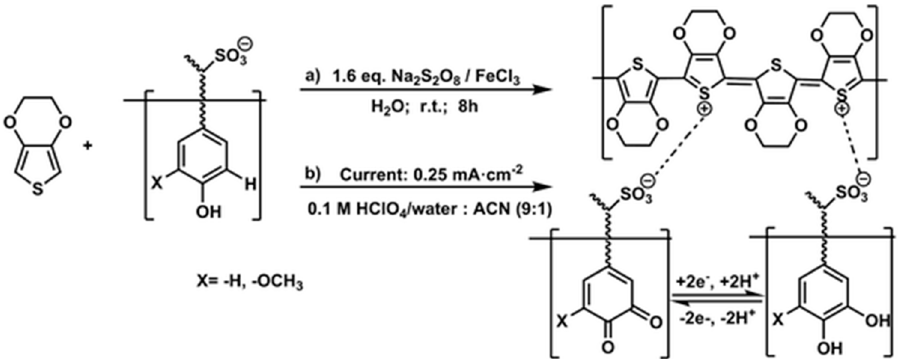
Figure 8. ( a ) Chemical oxidative and ( b ) electrochemical polymerizations of PEDOT/lignosulfonate composites. Reprinted with permission from ref. [51]. Copyright 2016 Royal Society of Chemistry.